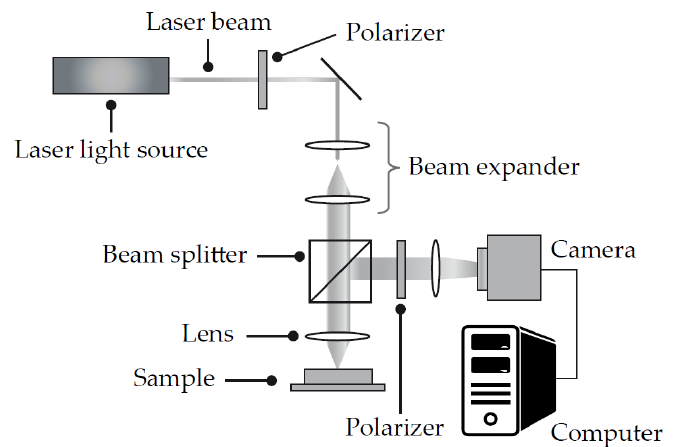
Figure 9. Schematic representation of the Laser Speckle Rheometry system. A laser light source shines a laser beam through a beam splitter onto a sample. The speckle pattern is detected by a camera and processed as described above. By analyzing the laser speckle pattern, the system can estimate the Brownian motion of the material. Brownian motion in such a sample is directly related to the viscoelastic properties of the material. During the blood clotting process, the change in viscoelastic properties can be evaluated and strongly correlated to parameters found in predicate viscoelastic hemostasis analyzers. Adapted from US Patent 8,772,039 B2 [35].